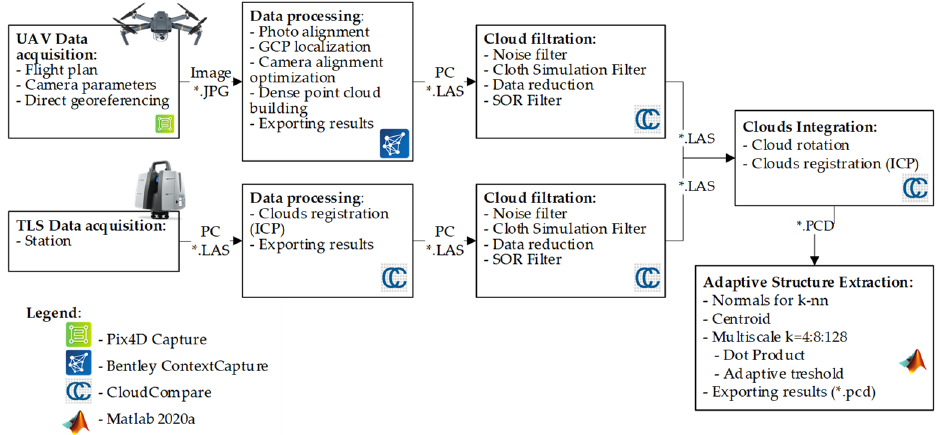
Figure 3. Data processing algorithm (PC: point cloud; *.JPG: JPG file format; *.LAS: LAS file format).